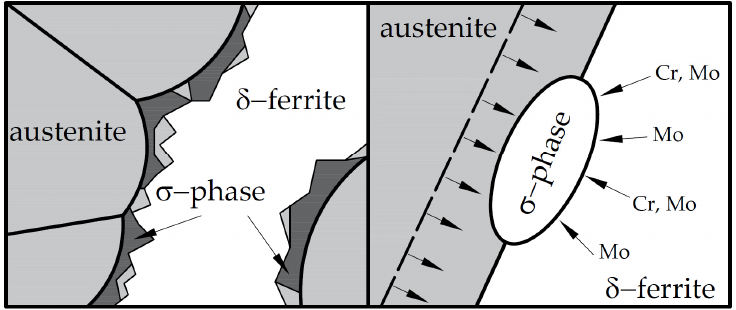
Figure 3. Kinetics of the eutectoidal decomposition of δ -ferrite in DSS.